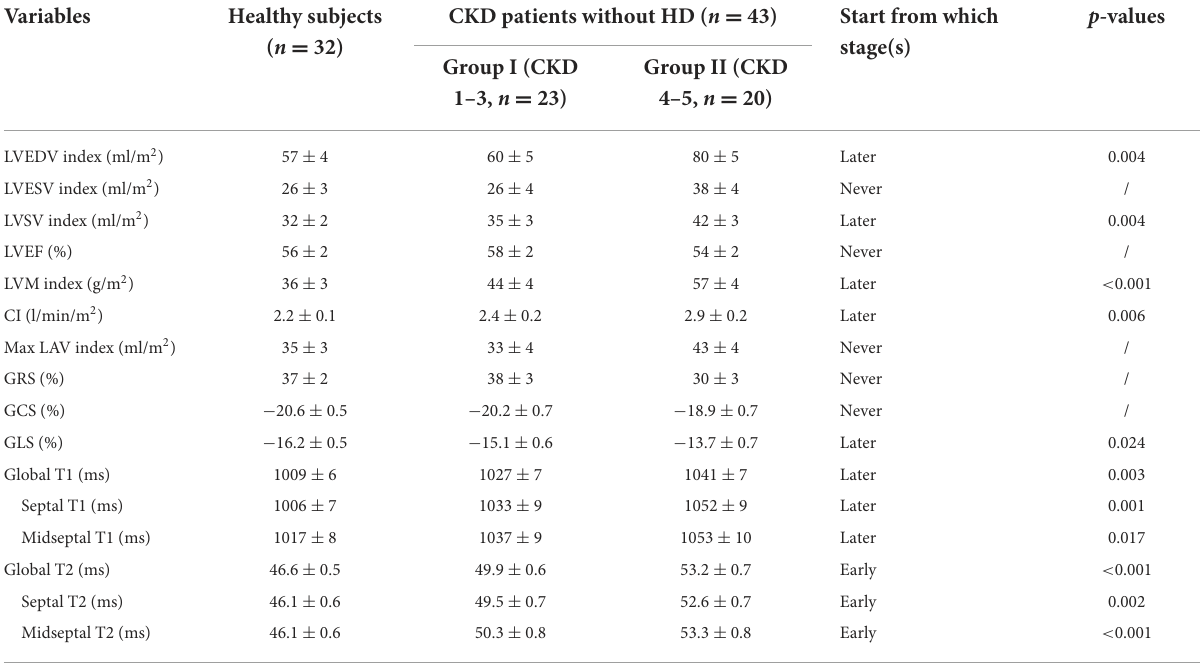
TABLE 3 MRI characteristics of the study subjects after adjustments for age, BMI, and HR. Variables